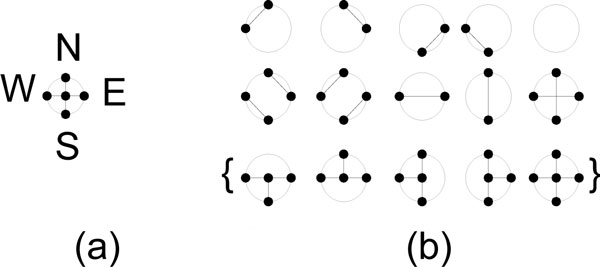
Port configurations on reconfigurable computing model. Allowable configurations on 4 port processing units; (a) shows the ports directions; (b) shows the 15 possible port connections, where the last five port configurations in curly braces are not allowed in Linear r-mesh (Lr-mesh) models.